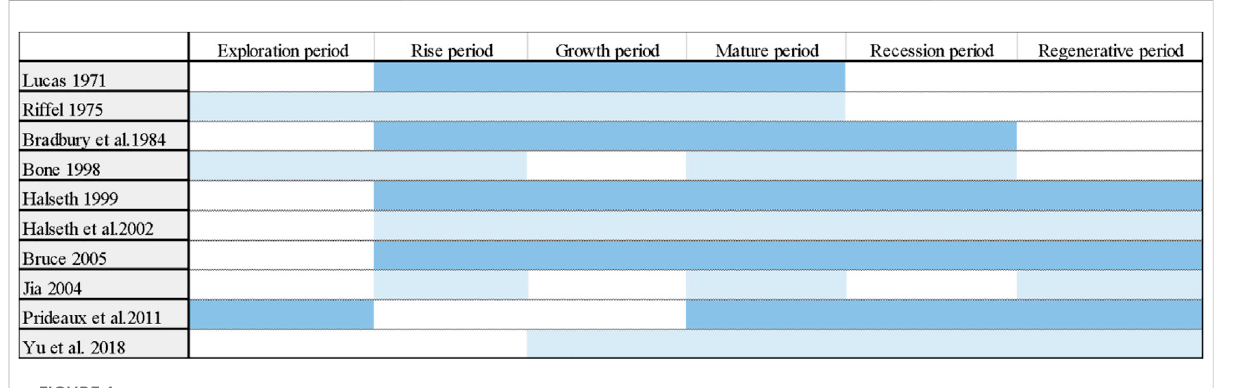
FIGURE 1 RBC development stage division.